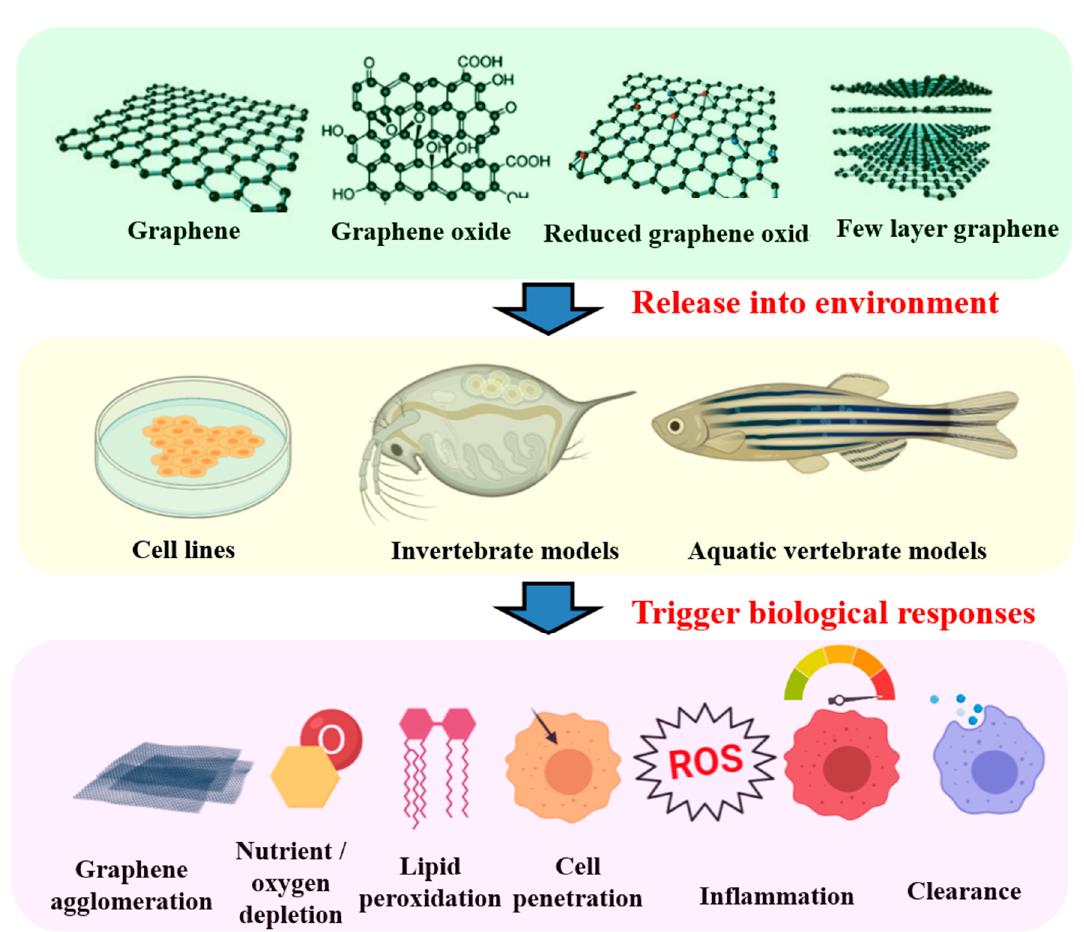
Figure 2. Current understanding of the potential toxicity induced by graphene-based nanomaterials graphene, graphene oxide, reduced graphene, and few-layer graphene are listed in the top panel (green color) in fish cells, invertebrates, embryo, and adult aquatic organisms. The common-used in vitro and in vivo aquatic animal models are listed in the middle panel (yellow color). The potential cytotoxicity induced by graphene-based nanomaterials is summarized in the bottom panel (pink color).